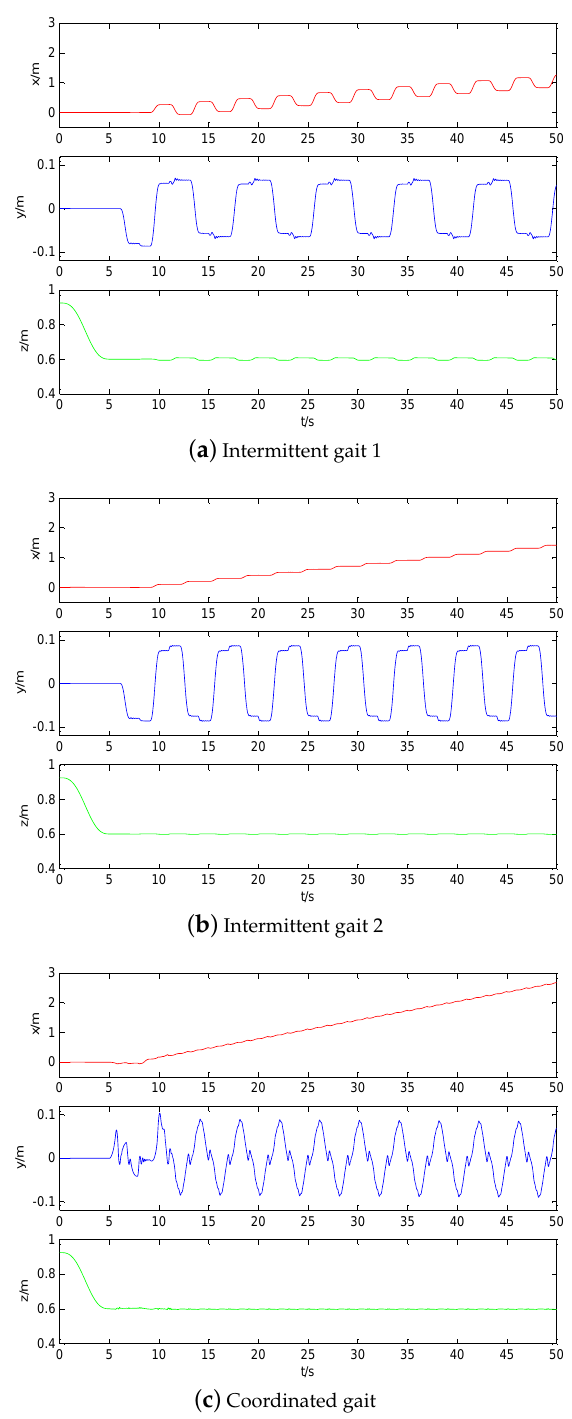
Figure 10. Comparison of CoM trajectory of three static